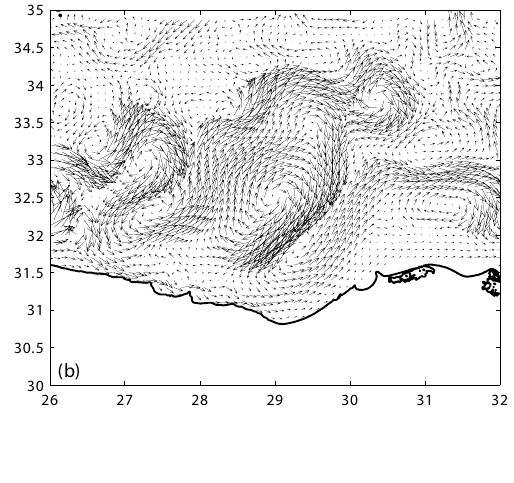
Kassos straits. The main part of this flow follows a westward path, forming a dipole to the north of Crete and a large-scale cyclonic circulation within the Mirtoan basin. The